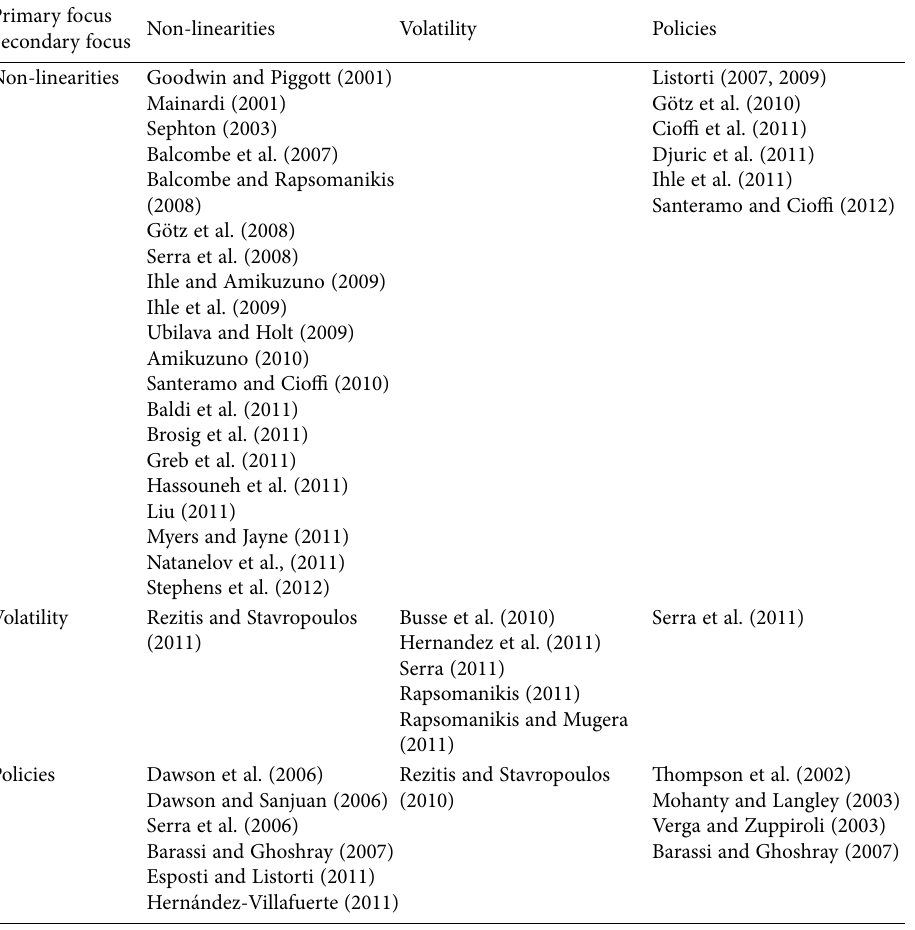
Table 1. Tentative mapping of the recent contributions on horizontal agricultural price transmission Primary